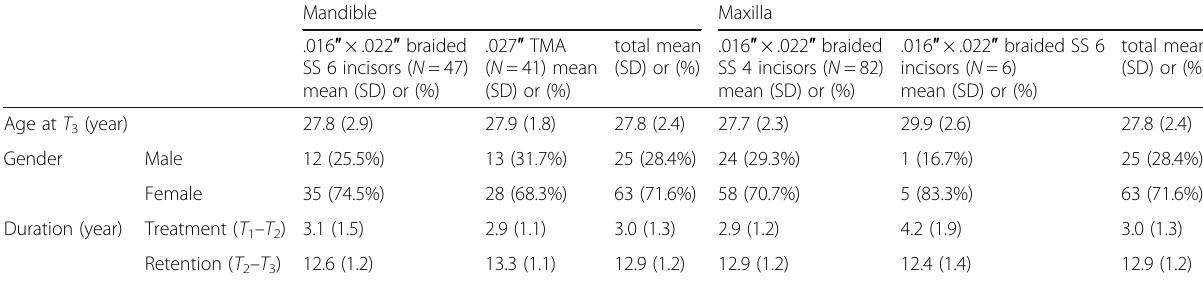
Table 1 Baseline characteristics of the two mandibular and the two maxillary retainer groups Mandible